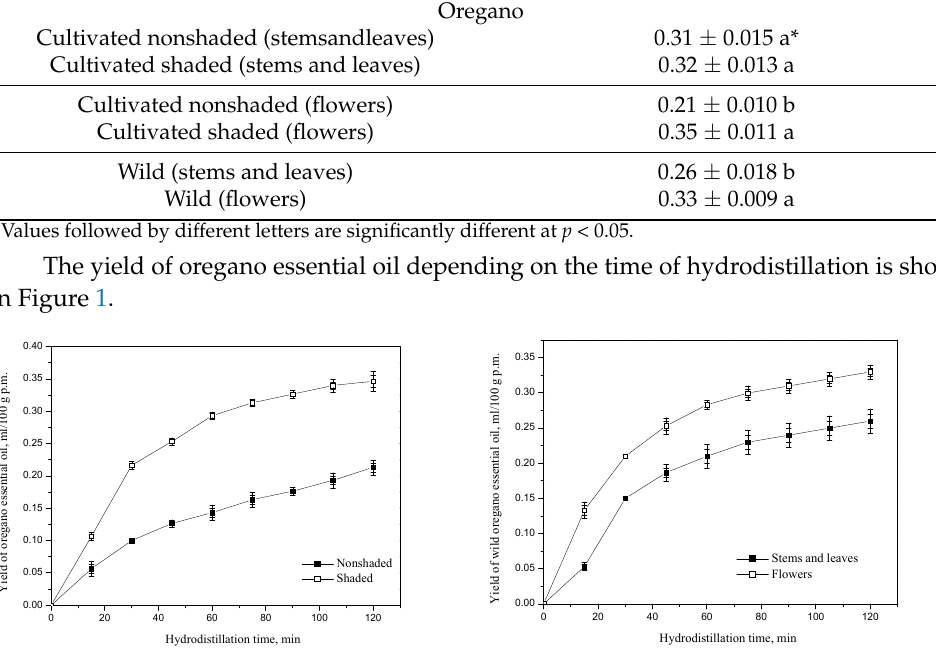
Table 2. Yield of essential oil from different parts of the cultivated (shaded and nonshaded) and wild oregano ( Origanum vulgare subsp. vulgare L.) obtained after 120 min of hydrodistillation (hydromodule 1:10 m / v ). Sample Essential Oil Yield, mL/100 g p.m. Oregano Cultivated nonshaded (stemsandleaves)